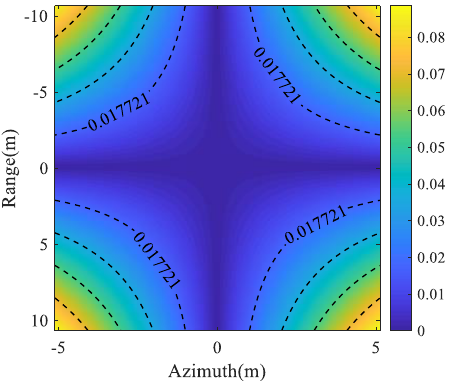
Figure 3. The phase error with range history simplification.